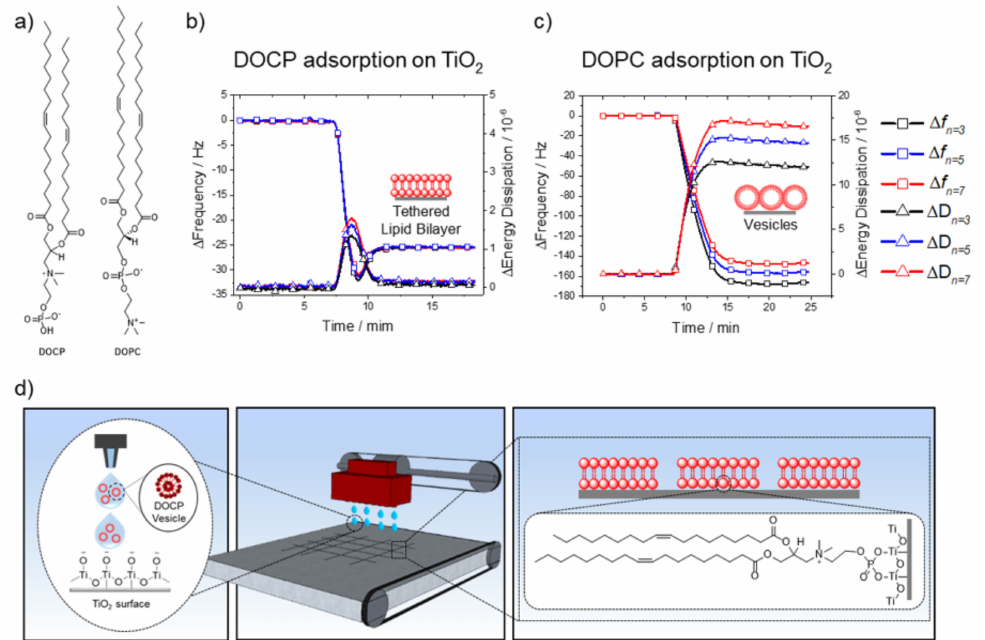
Figure 1. ( a ) Chemical structures of DOCP and DOPC phospholipids: DOCP is an inverted headgroup derivative of the zwitterionic DOPC phospholipid. ( b ) QCM-D plot of DOCP lipid vesicle adsorption onto a TiO 2 surface, and subsequent rupture to form a planar and tethered lipid bilayer (decreased frequency (Hz) indicates mass increase of the lipid adlayer, and increased energy dissipation (10 − 6 ) correlates with film viscoelasticity). ( c ) QCM-D plot of DOPC lipid vesicle adsorption onto a TiO 2 surface, whereby adsorbed vesicles remained intact and did not rupture. ( d ) Schematic illustration of inkjet-printed DOCP lipid vesicles to form macroscale and microscale patterns comprising tethered phospholipid bilayers on a TiO 2